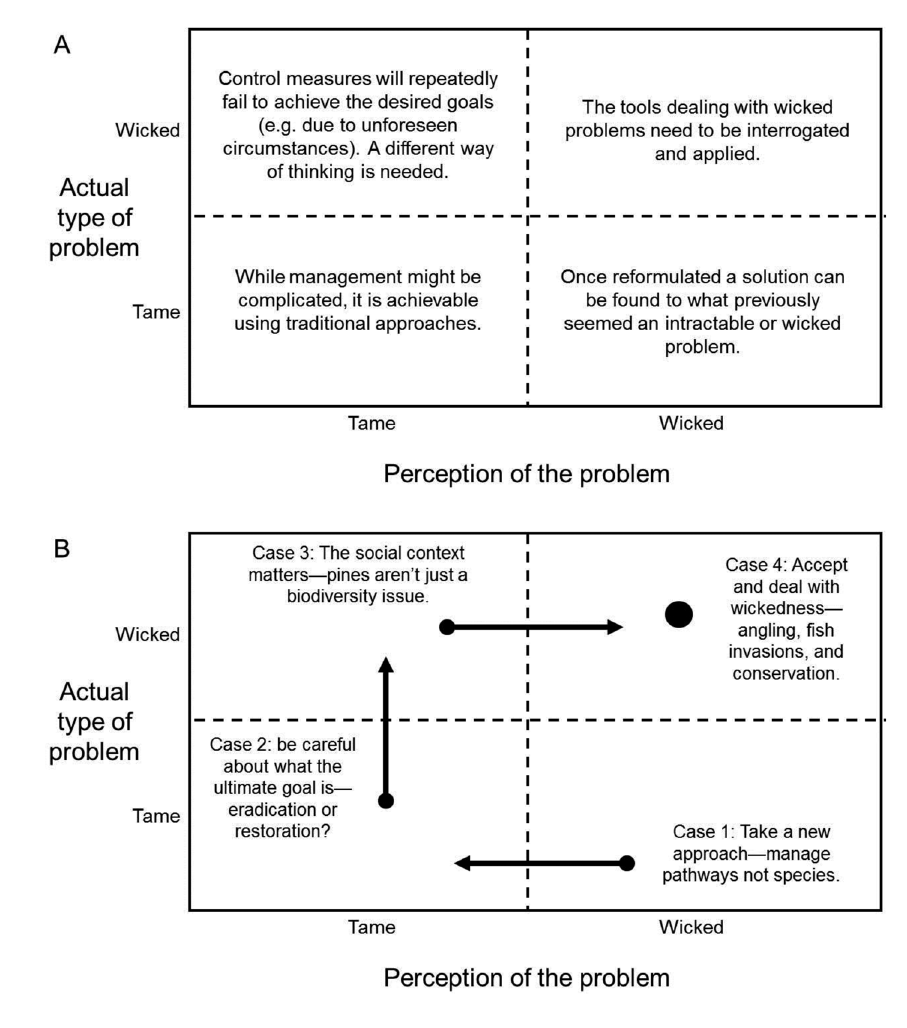
Figure 1. Conceptual diagram of perceived and real wicked problems in managing biological invasions. Panel A represents a matrix of how perceived and actual wickedness can influence the outcome of man- agement; Panel B illustrates emergent lessons from the four case studies of invasive species management discussed here. Vectors represent shifts in problem perception and management paradigms necessary for improving the manageability of each case